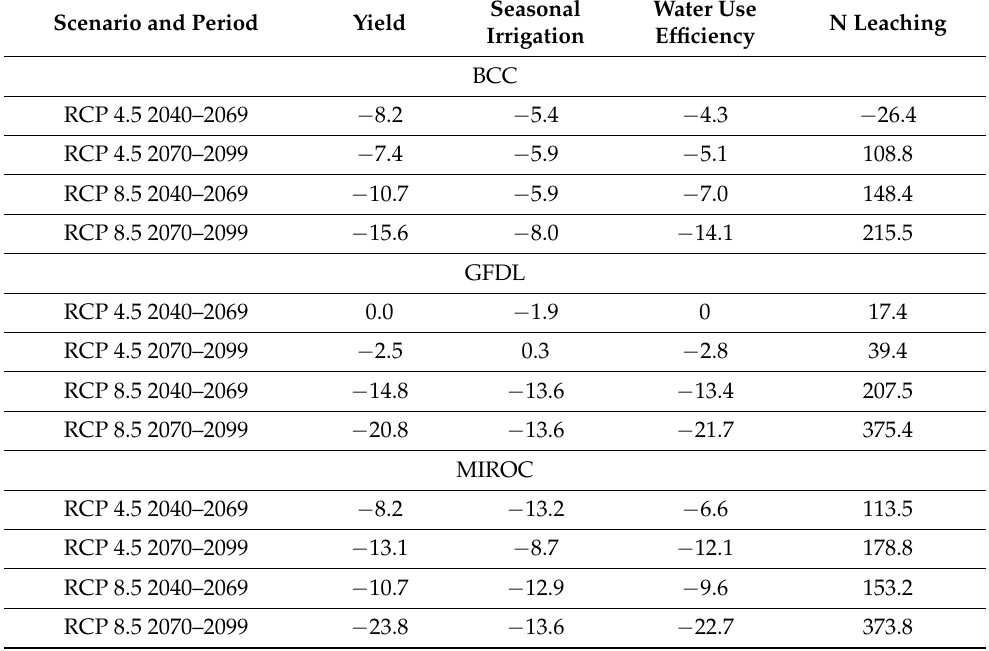
Table 4. Percentage differences (future–baseline) between the simulated mean baseline values and simulated mean future values for yield, WUE, seasonal irrigation requirements and N